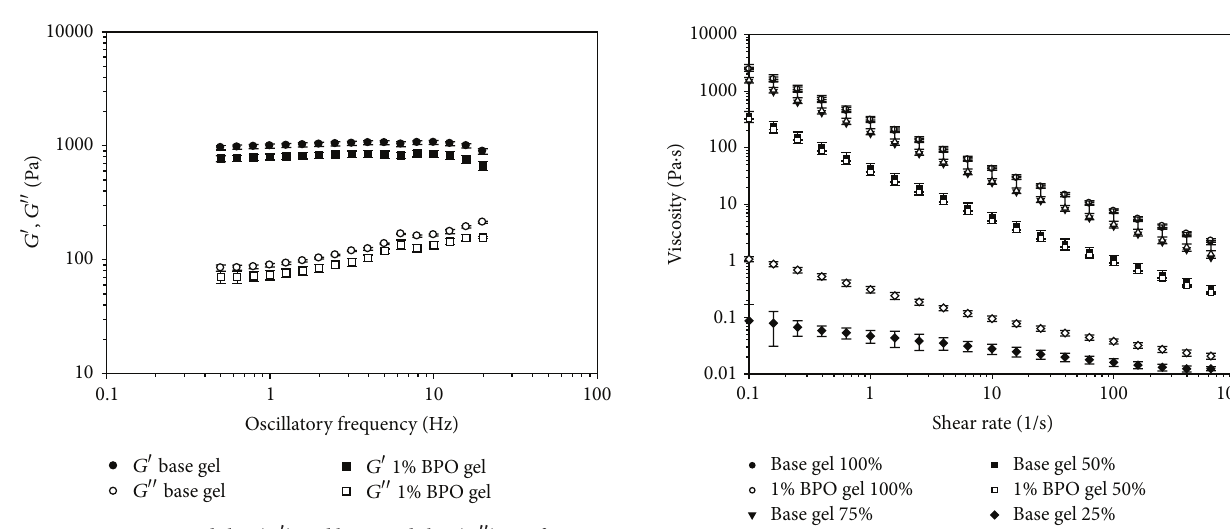
Figure 5: Storage modulus ( 𝐺 󸀠 ) and loss modulus ( 𝐺 󸀠󸀠 ) as a function of oscillatory frequency (Hz) on the base gel and 1% BPO gel. Experiment was conducted in triplicate. Mean values and standard deviations of three experiments are shown.